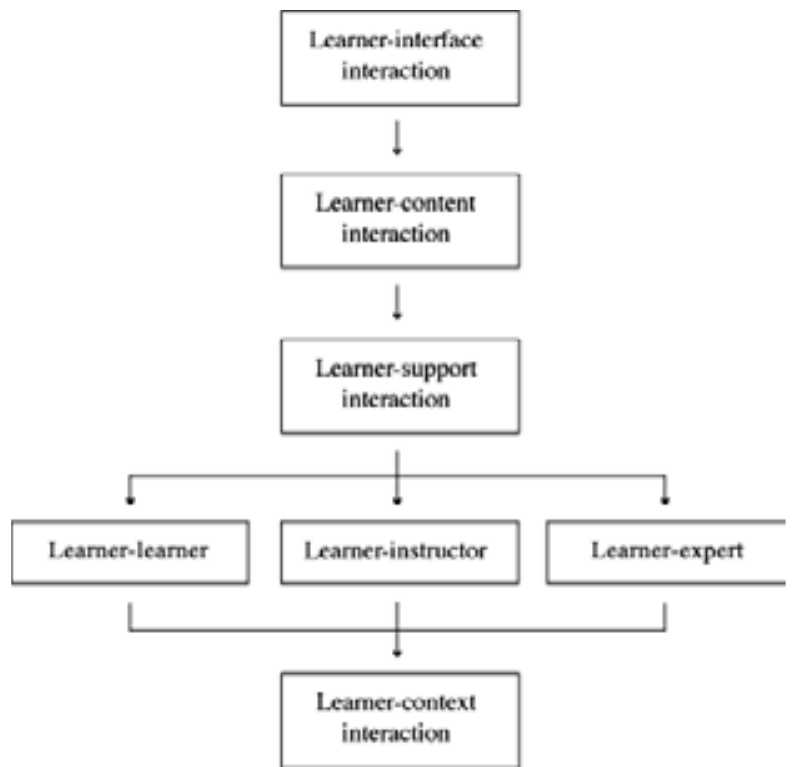
Figure 1 . Ally’s levels of interaction in online learning ( Theory and Practice of Online Learning , 2004, p. 21). Reprinted with